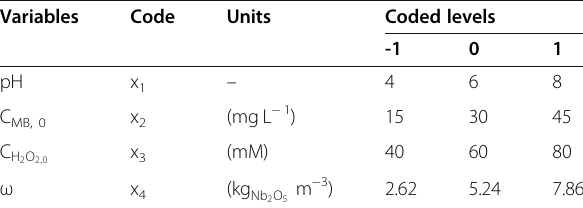
Table 1 Independent variables and their coded levels for the central composite